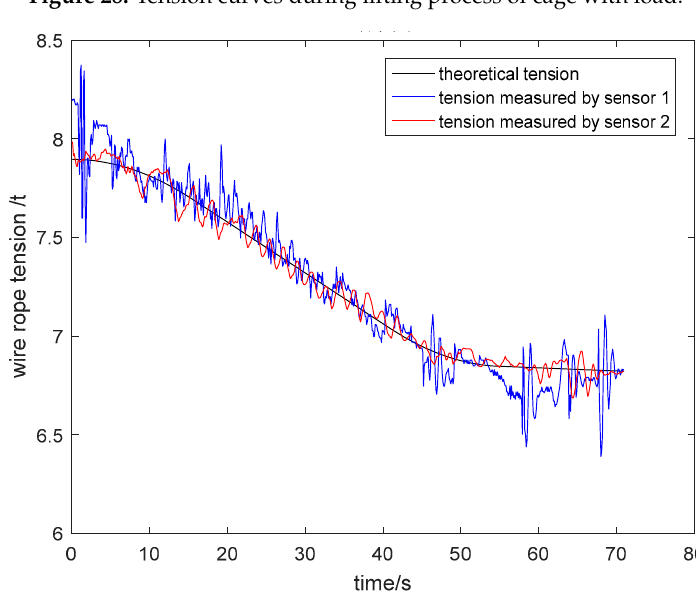
Figure 29. Tension curves during descending process of cage with load.